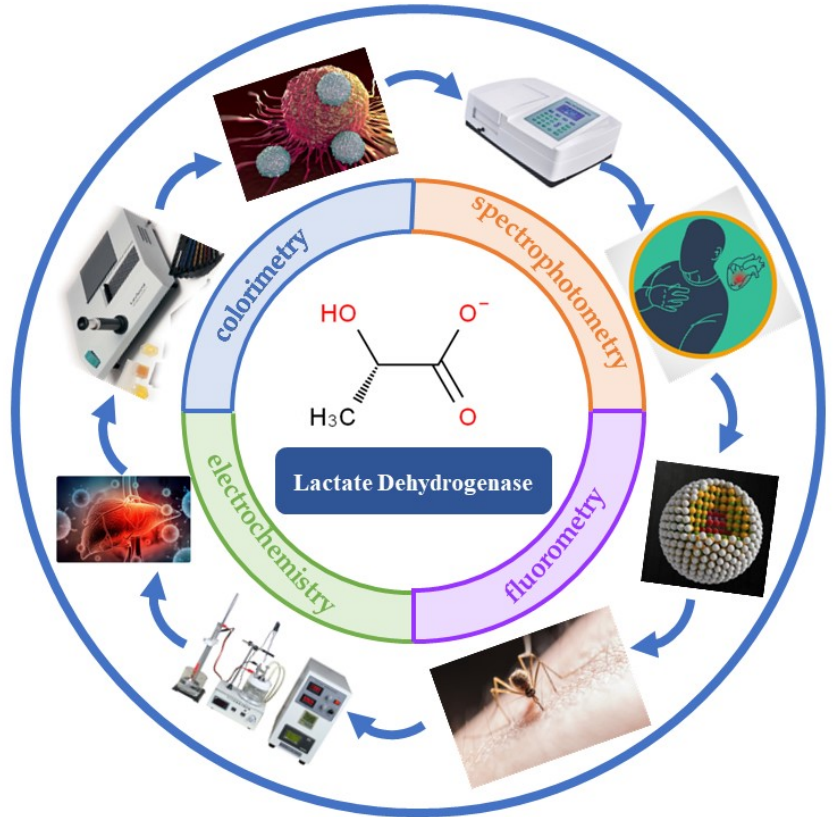
Figure 2. Lactate dehydrogenase applications in medical sectors.